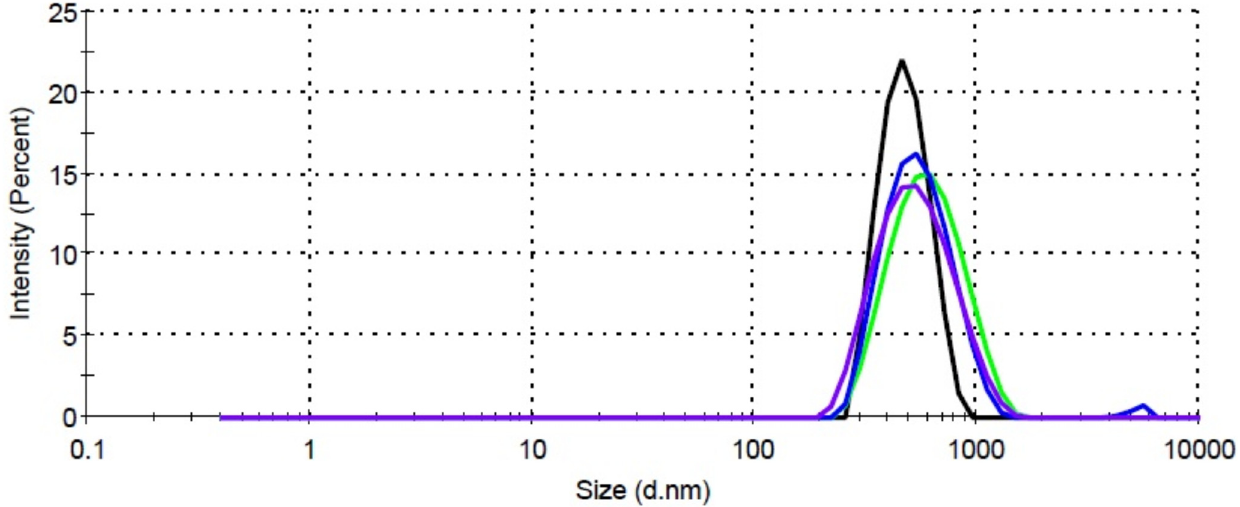
Figure 1. Size distribution of unmodified SiO 2 dispersion (SiO 2 -2 black) and for organo-modified SiO 2 dispersions: SiO 2 -2-Org1 (green), SiO 2 -2-Org2 (blue), and SiO 2 -2-Org3 (purple).